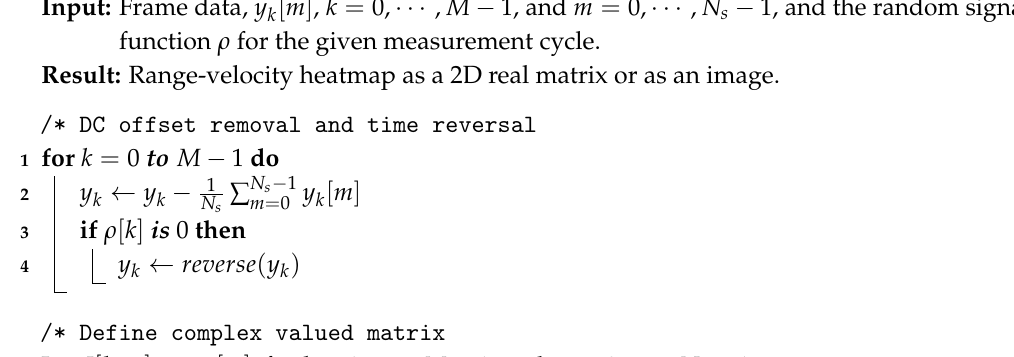
Algorithm 2: AV Sensor (a.k.a. Radar DSP)